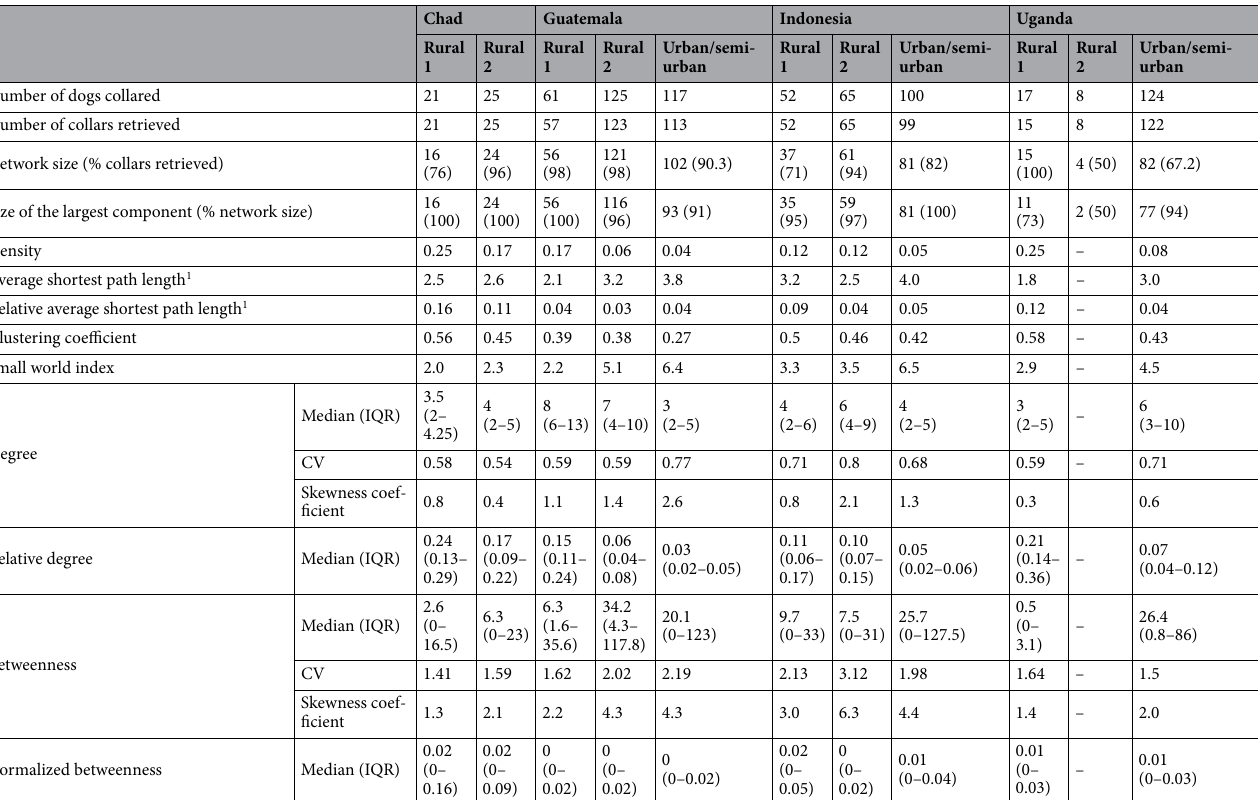
Table 1. Network statistics of the 11 dog contact networks. The size of the network corresponds to the number of connected dogs in each study area (i.e. dogs with at least one contact). The relative degree correspond to the dog individual degree divided by the network size and the normalized betweenness correspond to the dog individual betweenness divided by the maximum betweenness in the network. CV = coefficient of variation, IQR = Interquartile range. 1 Of the largest component. The characteristics of the dogs included in the current study were presented in Warembourg et al 34